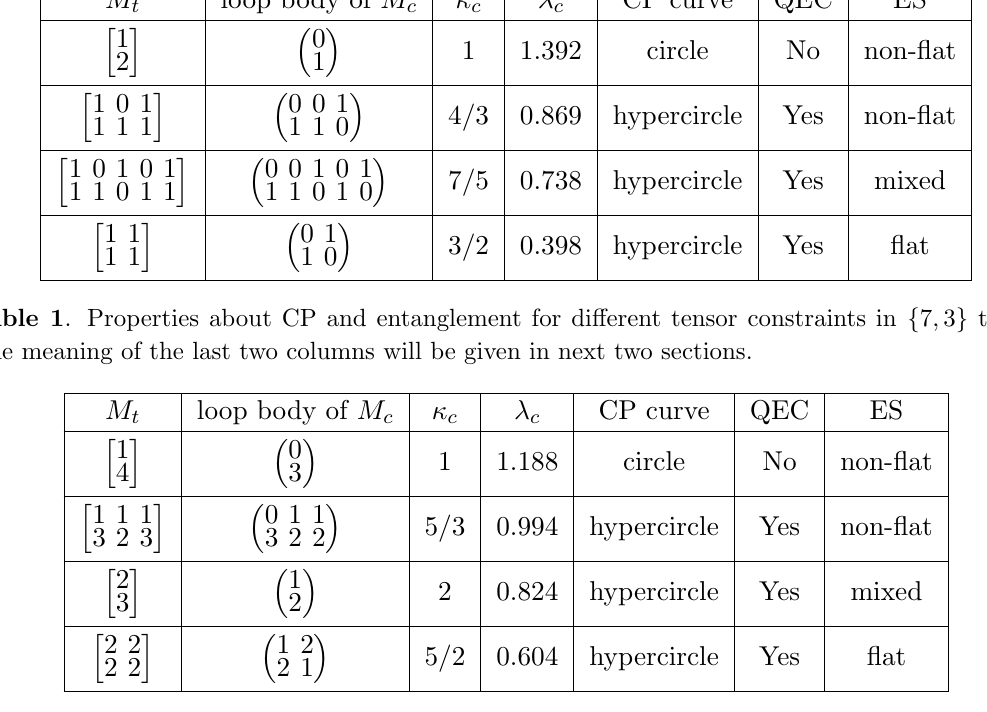
Table 2 . Properties about CP and entanglement for di(cid:11)erent tensor constraints in f 4 ; 5 g tiling. starting from A and from (cid:22) A respectively, which will be further discussed in next